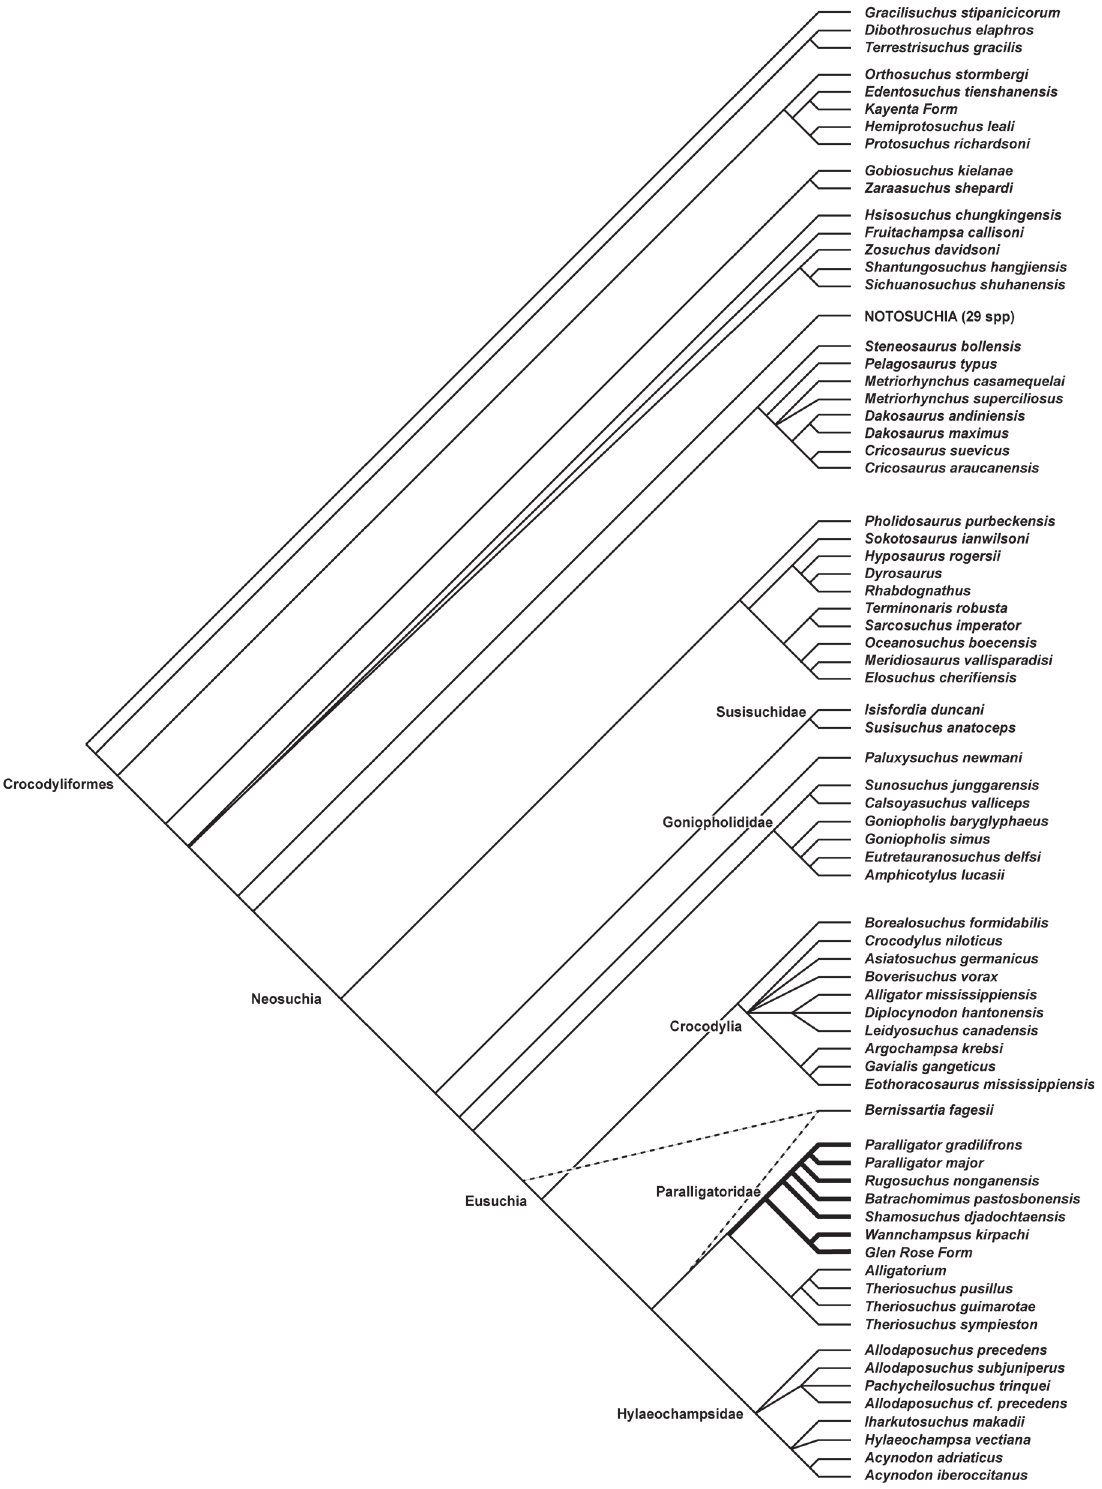
Fig 14. Reduced strict consensus of 108 equally optimal trees recovered from maximum parsimony analysis of 101 ingroup taxa and 318 phenotypic characters. Trees rooted on Gracilisuchus stipanicicorum . Two equally optimal positions of Bernissartia fagesii shown with dotted line (length = 1662, CI = 0.239, RI =